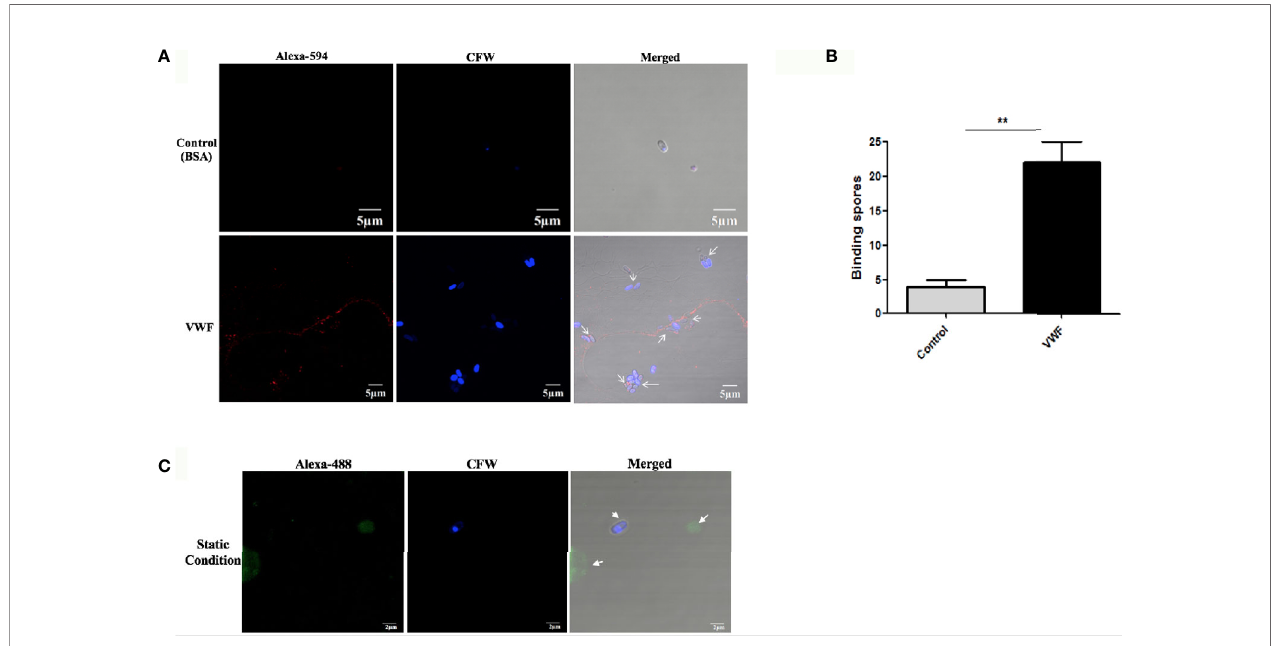
FIGURE 1 | E. hellem spores attach to FL-VWF under fl ow. (A) Representative images of control protein (BSA, top) or FL-VWF (bottom), both at 20 µg/ml were perfused through the micro fl uidic chamber with E. hellem spores (10 5 cells/ml) under fl ow at 5 dyn/cm 2 , respectively. The channels were then washed, fi xed and stained by Alexa-594-labeled anti-VWF antibody and calco fl uor-white (CFW). The fl uorescent microscopy analysis showed that the VWF formed ultra large multimers under fl ow (red), and E. hellem spores (blue) attached to the strings of ultra large VWF strings, as pointed out by white arrows in the right fi gures. (Scale bar = 5 µm). (B) The number of binding spores in the channels were calculated, based on three independent studies with 8 random fi elds for each study (F(1,23) = 2.25, **P <0.01). (C) Under static conditions with no shear, the FL-VWF clumped and aggregated together (green). The E. hellem spores (blue) are not able to bind to clumped